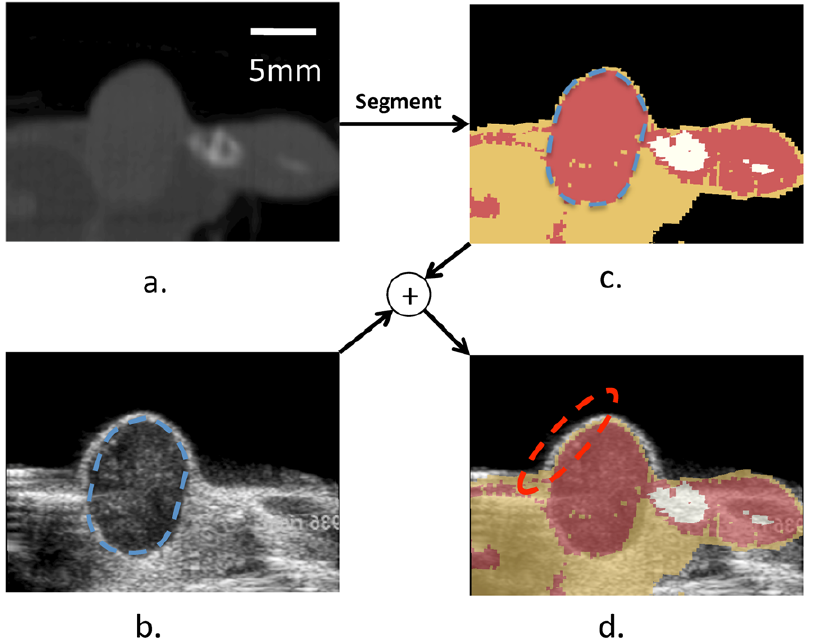
Figure 6. Combined CT/US characterizes tissue. (a) CT slice of a hindlimb tumor corresponding to the US slice in (b). The segmented CT slice is shown in (c) and overlaid on the US image in (d). The combined segmented CT/US image identifies fat proximal to and surrounding the tumor during ultrasonic imaging, with registration accuracy on the order of 1 mm. Nearby bone is obvious in the CT image (c) but not immediately visualized by US (b).